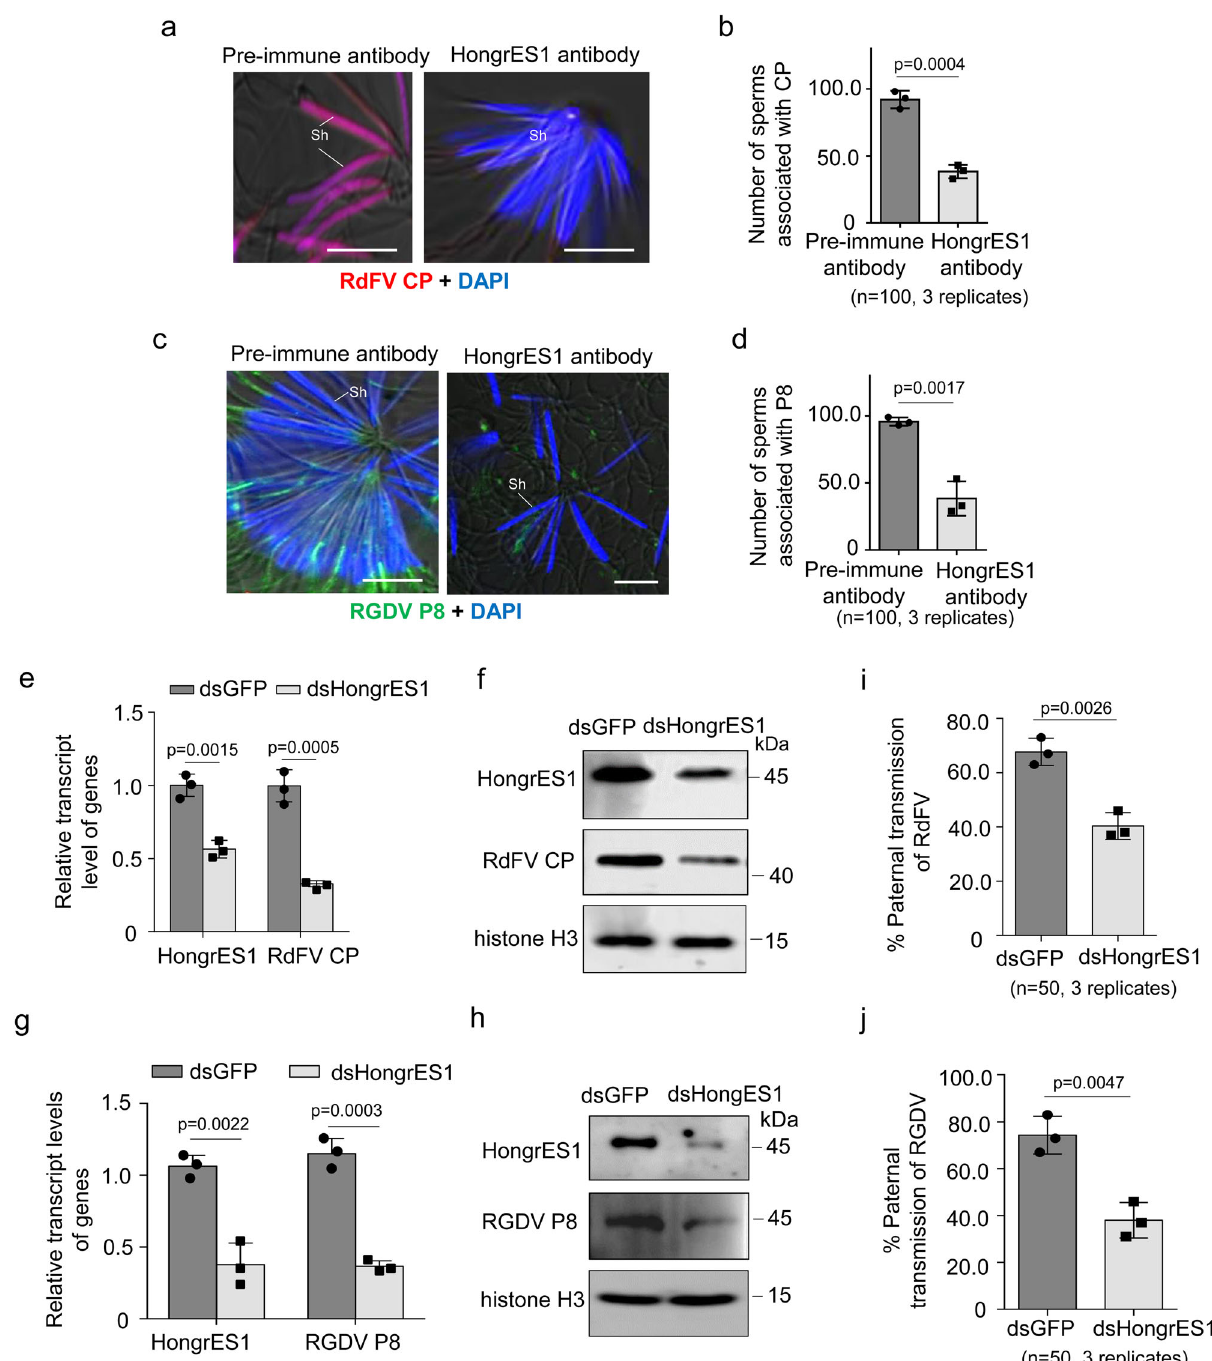
Fig. 4 | HongrES1 mediates speci fi c binding of RdFV or RGDV to sperms for paternaltransmissionbymale R.dorsalis .a , b ReducedCP-spermassociationby pretreatment with HongrES1 antibody. Live sperms dissected from 30 virus-free testes were incubated with puri fi ed CP and pre-immune antibody or with puri fi ed CP and HongrES1 antibody, then stained with CP-rhodamine (red) and nuclear dye DAPI (blue) to indicate sperm head. Means (±SD) are shown from 100 sperms (3 replicates, two-tailed t-test). Sh, sperm head. Bars, 10 μ m. c , d Reduced RGDV- spermassociationbypretreatmentwithHongrES1antibody.Livespermsdissected fromvirus-freetesteswereincubatedwithpuri fi edRGDVparticlesandpre-immune antibody, or with puri fi ed particles and HongrES1 antibody, then stained with P8- rhodamine (red) and DAPI (blue). Means (±SD) are shown from 100 sperms (3 replicates,two-tailedt-test).Sh,spermhead.Bars,10 μ m. e − h Effectsofknockdown